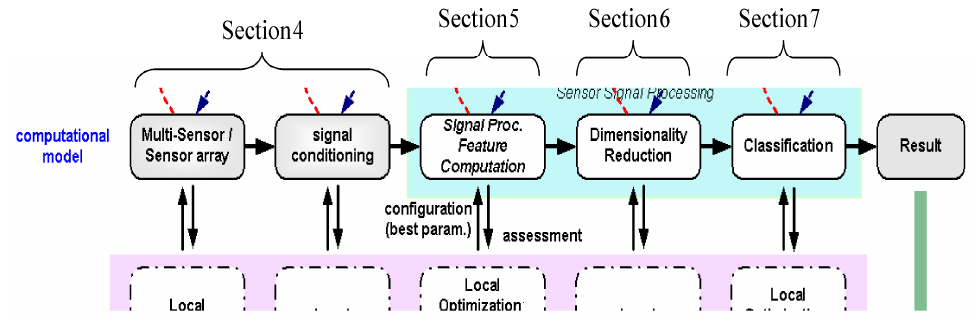
Figure 15. Demonstration of the design steps in the ADIMSS automated design